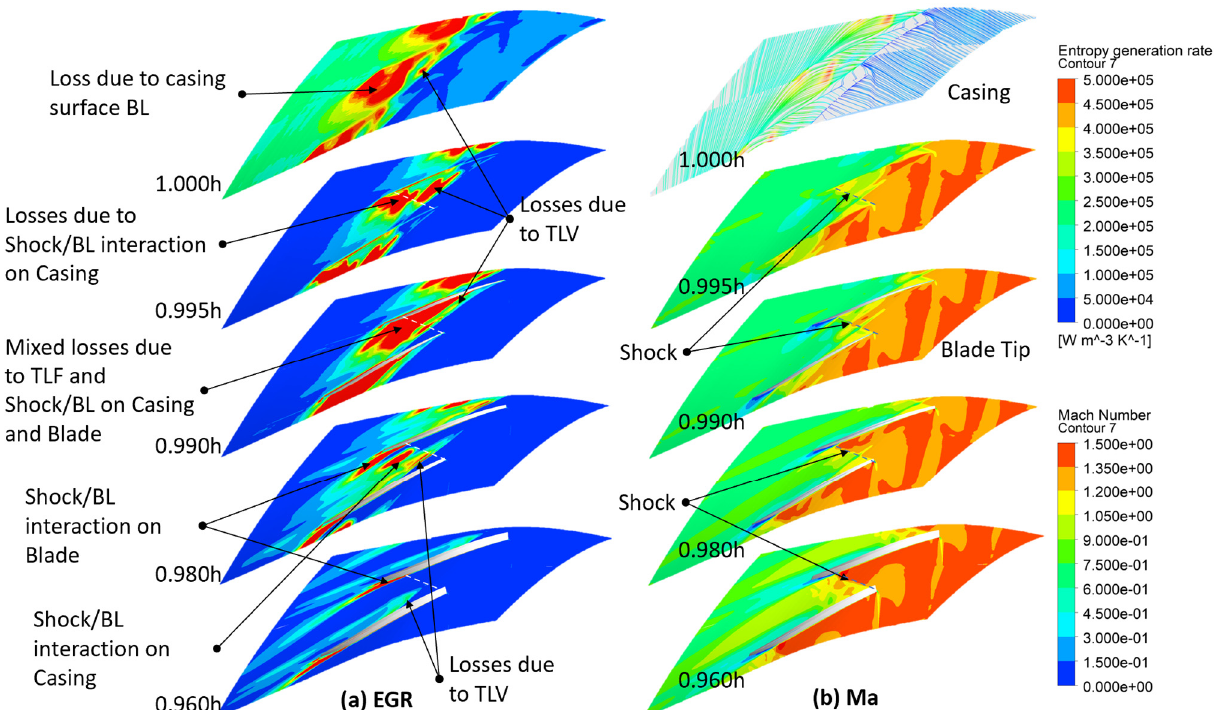
Figure 11. Contours of ( a ) entropy generation rate (EGR) and ( b ) Mach number (Ma). Some of the abbreviations are TLF = tip leakage flow, TLV = tip leakage vortex, and BL = boundary layer.